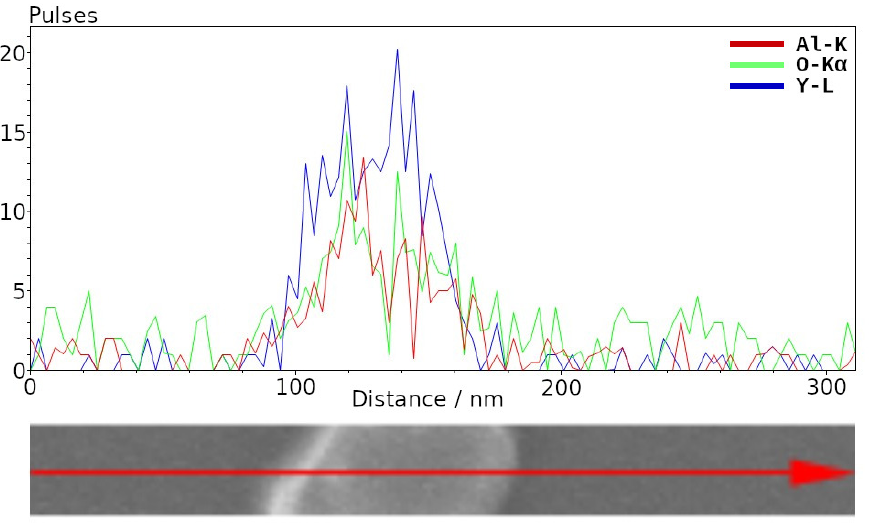
Figure 2. EDS profile of a selected nanoparticle confirming YAG composition. The erbium concentra- tion of 2 at.% is below the sensitivity of the EDS detector.